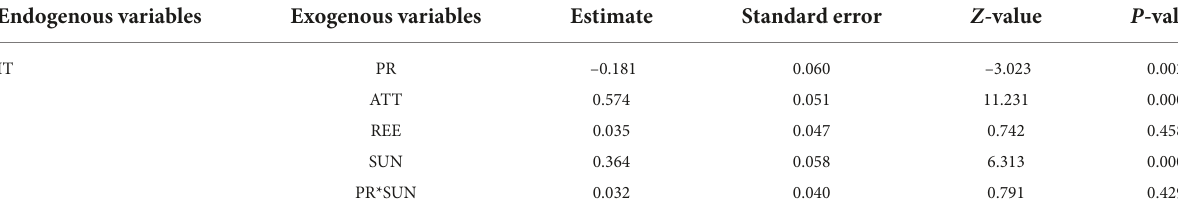
TABLE 9 Effect of a